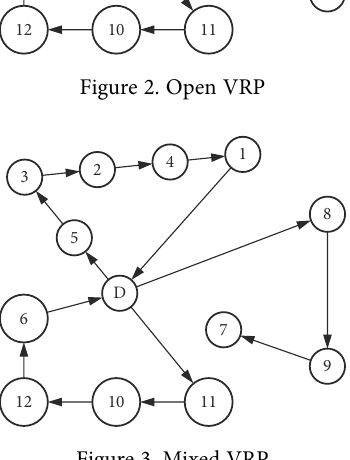
Figure 2. Open VRP